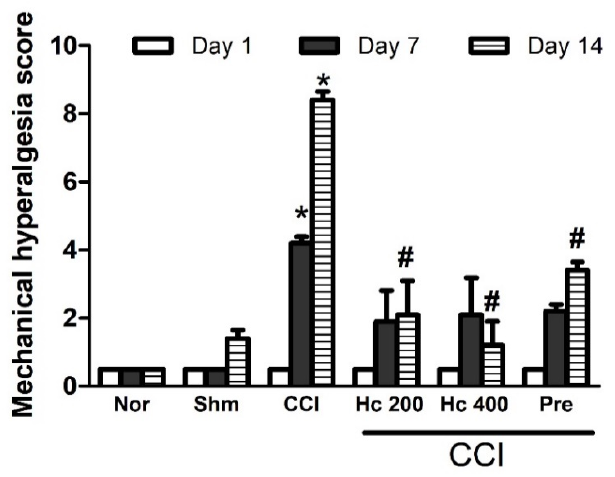
Figure 7. Effect of H. campechianum flower extract (p.o., 200 and 400 mg/kg) on the score of mechanical hyperalgesia in rats with neuropathic pain induced by spinal nerve ligation. Withdrawal duration was measured in seconds and ranged from 0.5 sec for the brief normal response to 20 sec (the cut-off time). Data are presented as mean values ± S.E.M (n = 5). * p < 0.05, compared to sham group; # p < 0.05, compared to CCI group at the corresponding time points. CCI, chronic constriction injury; Hc, H. campechianum ; Nor, normal; Pre, pregabalin; Shm, sham.